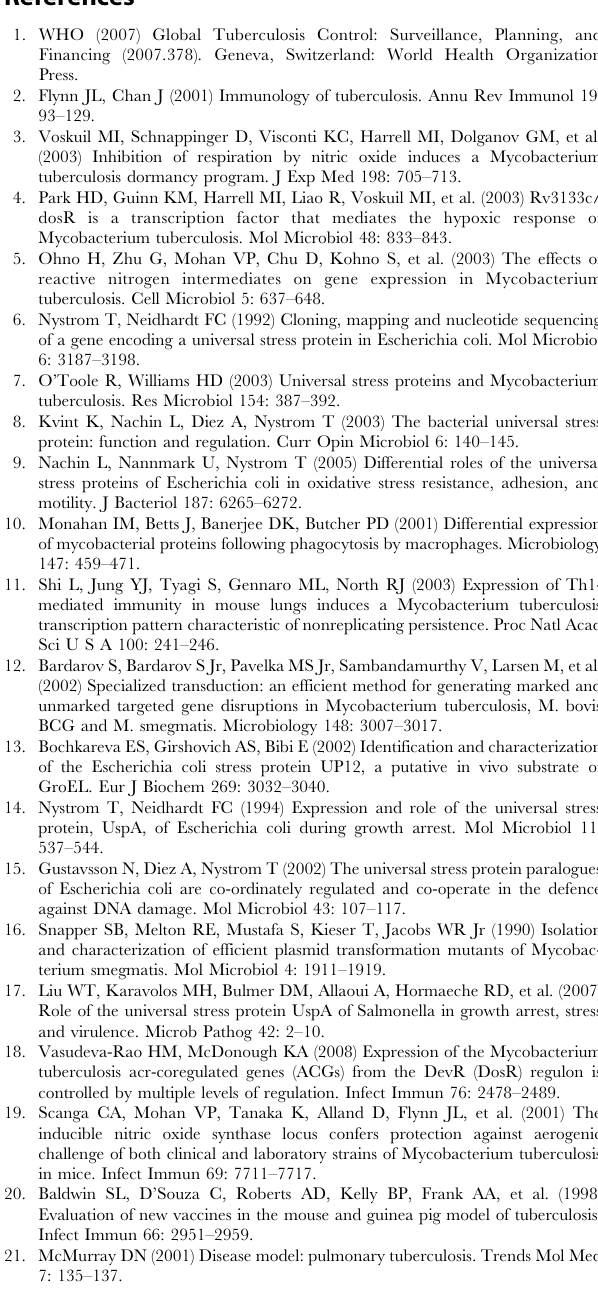
Found at: doi:10.1371/journal.ppat.1000460.s006 (0.03 MB DOC) Text S1 Supporting materials and methods. Found at: doi:10.1371/journal.ppat.1000460.s007 (0.03 MB